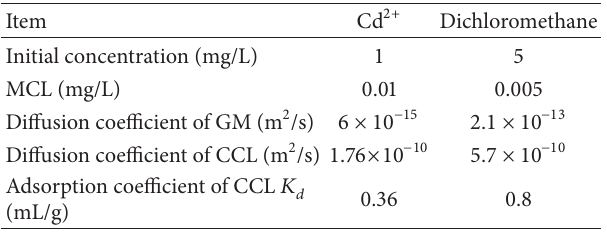
Table 2: Hydraulic conductivity, porosity, and dry density in CCL. Table 3: Characteristics of the contaminant transportation.